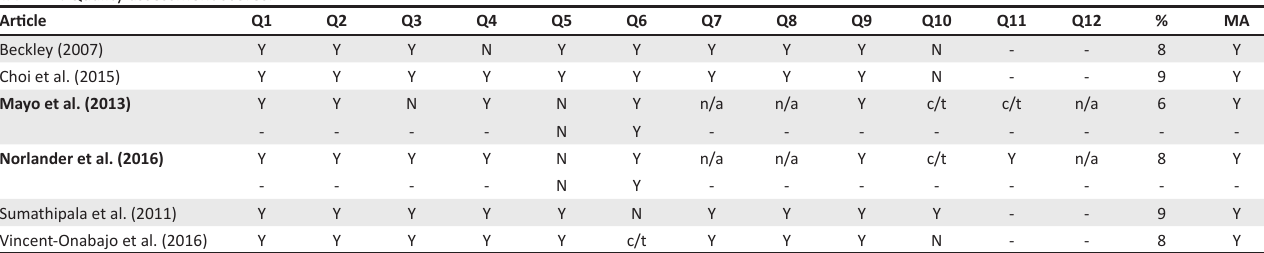
TABLE 2: Quality assessment